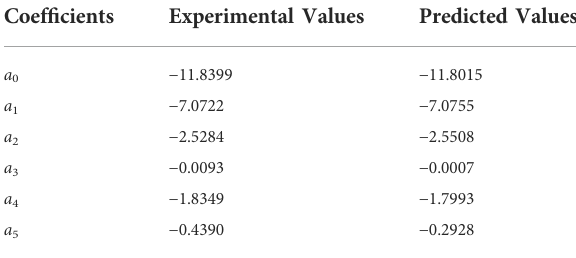
TABLE 1 Experimental a i values versus predicted a i values. Coef fi cients Experimental Values Predicted